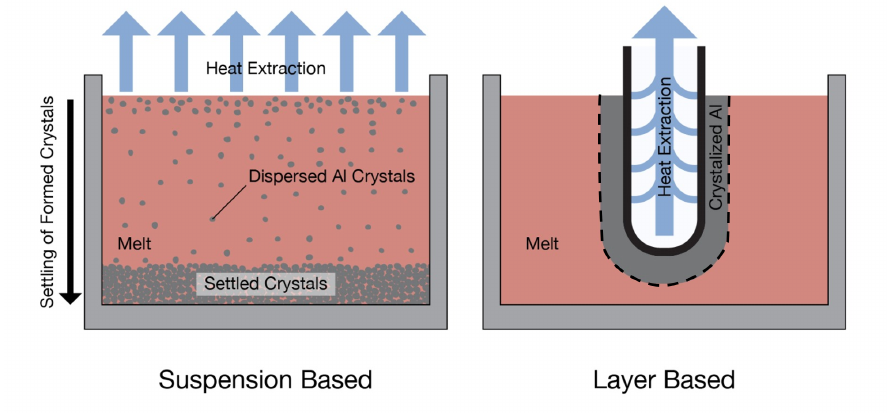
Figure 6. Sketch representation of suspension-based ( left ) and layer-based ( right ) segregation methods.